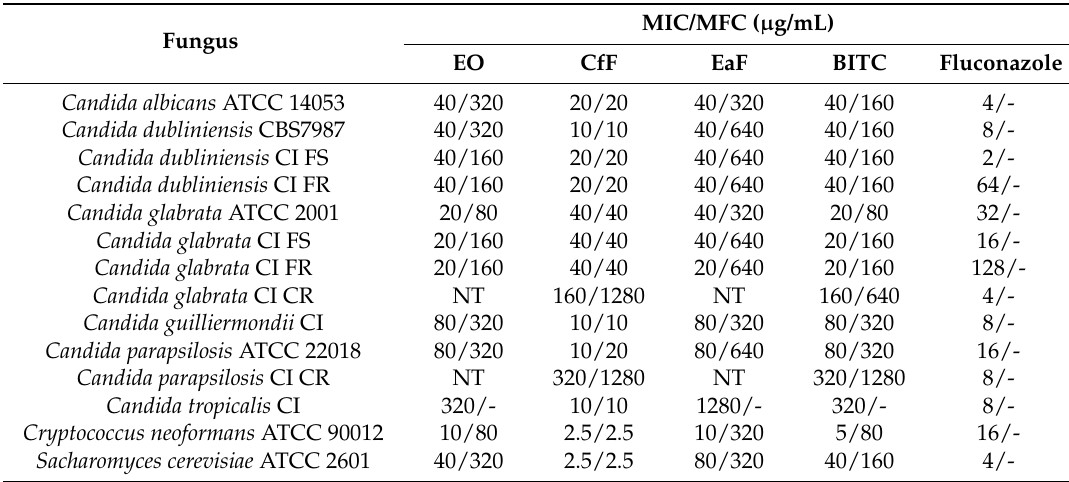
Table 2. Antifungal activity of the essential oil and fractions from the CE of Tropaeolum pentaphyllum tubers, against yeast fungi.